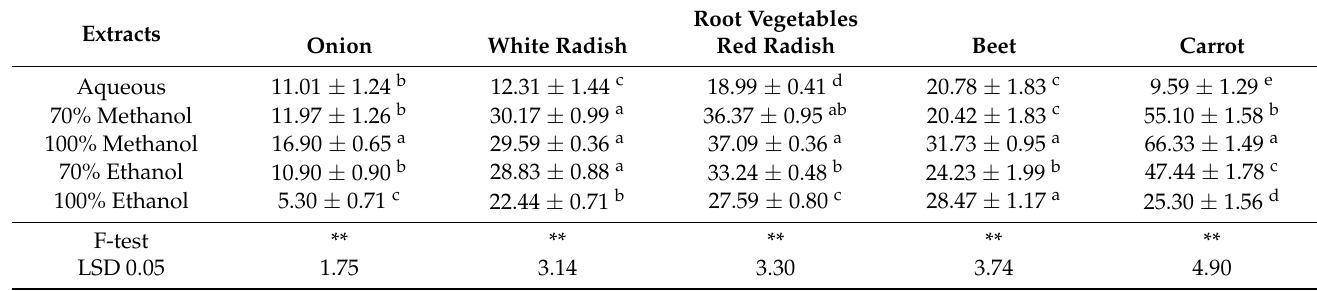
Table 4. Total phenolic content (mg GAE/g) of the aerial part of selected root